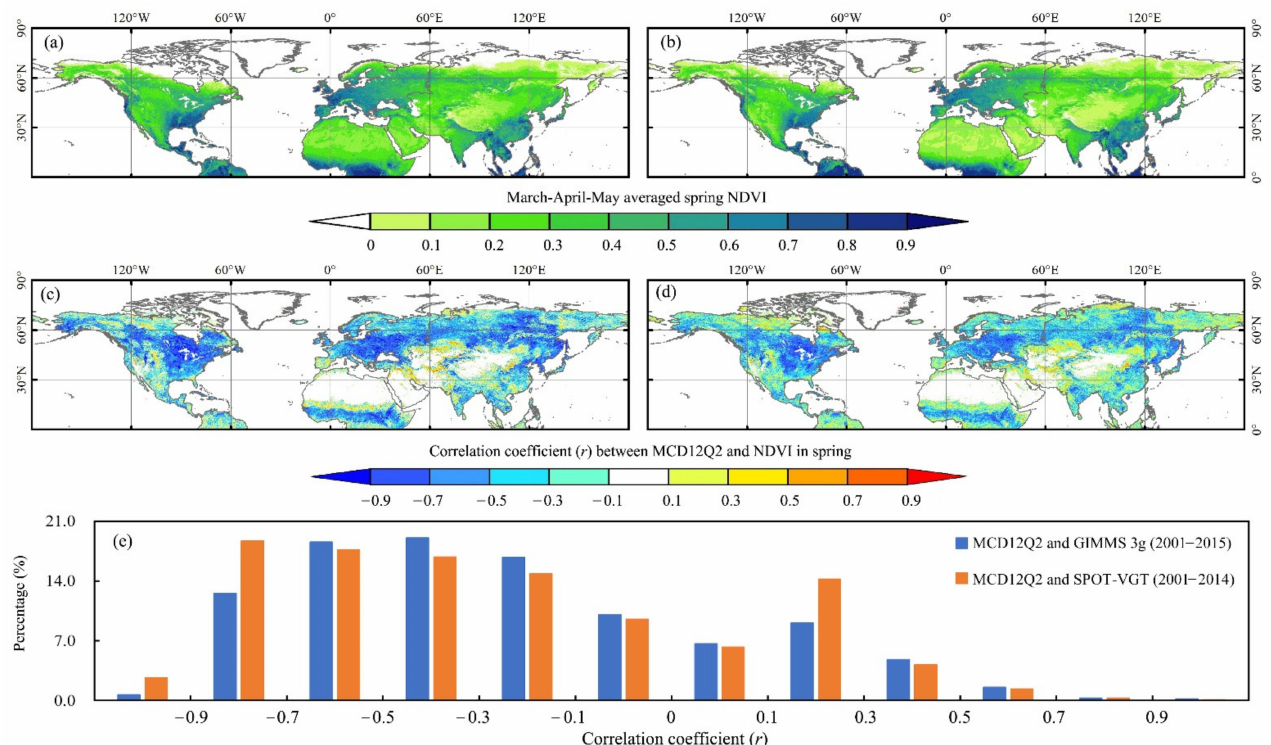
Figure 7. ( a ) The 14-year averaged spring NDVI calculated from the SPOT-VGT during 2001–2014. ( b ) The 15-year averaged spring NDVI calculated from the GIMMS 3g during 2001–2015. Correlation coefficients between the SOS from the MCD12Q2-C6 and the spring NDVI series from ( c ) the SPOT- VGT during 2001–2014 and ( d ) the GIMMS 3g during 2001–2015. ( e ) Histogram of correlation coefficients between the SOS from the MCD12Q2-C6 and the spring NDVI series from the SPOT-VGT and GIMMS